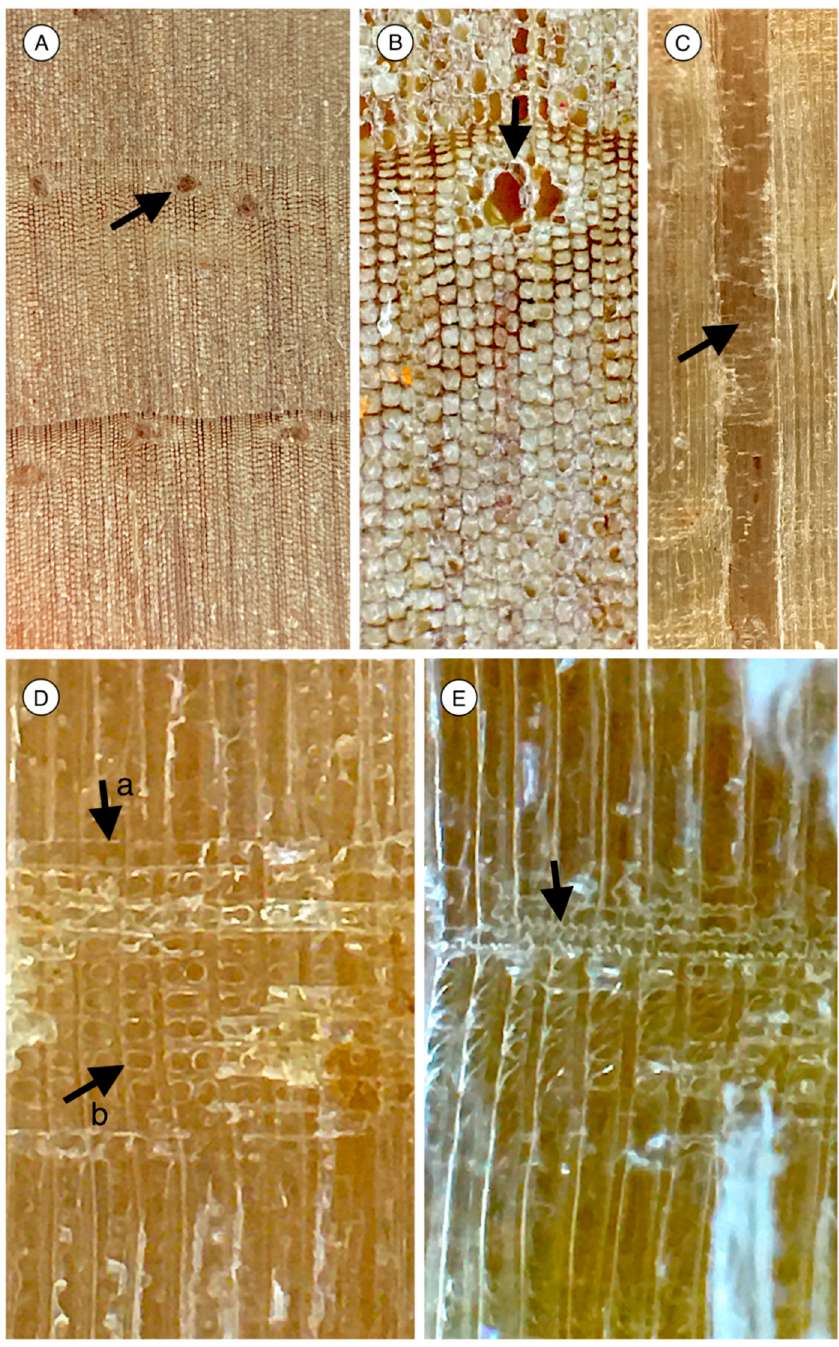
Figure 2. Elements visible with 24× and 400× lenses in softwoods. Pinus koraiensis Sieb. and Zucc. ( A ) Axial resin canals (24× lens). ( B ) Thin-walled epithelial cells in axial resin canal (400× lens). ( C ) Axial resin canal in radial section (24× lens). ( D ) ( a ) Smooth-walled ray tracheid; ( b ) window-like cross-field pit (400× lens). ( E ) Dentate ray tracheid in Pinus sylvestris L. (400× lens).